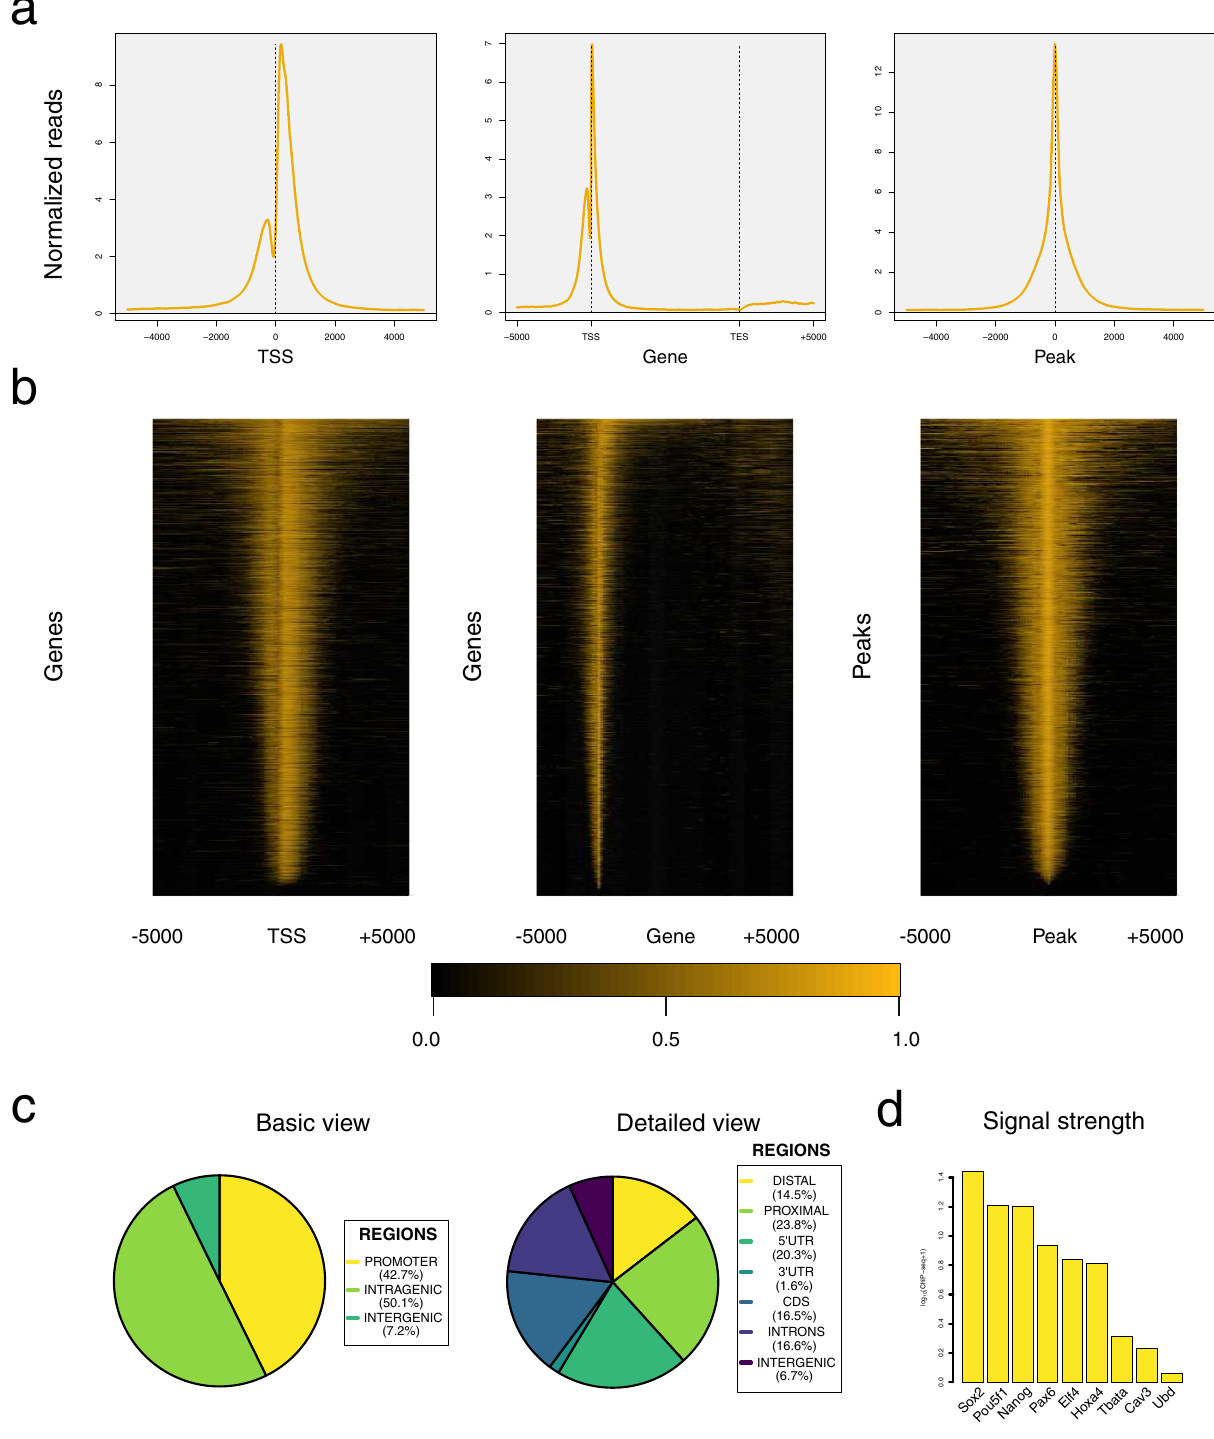
Figure 3. Basic analysis of the H3K4me3 ChIP-seq sample in mESCs using SeqCode. (a) From left to right: average distributions around the TSS of H3K4me3 target genes ( produceTSSplots) , along the gene body of the same genes ( produceGENEplots ), and around the center of H3K4me3 peaks ( producePEAKplots ). (b) From left to right: heatmap around the TSS of H3K4me3 target genes ( produceTSSmaps) , along the gene body of the same genes ( produceGENEmaps ), and around the center of H3K4me3 peaks ( producePEAKmaps) . (c) Basic and detailed genome distribution of H3K4me3 peaks ( genomeDistribution ). (d) ChIP-seq signal levels of selected genes ( recoverChIPlevels ). Raw data were retrieved from 32